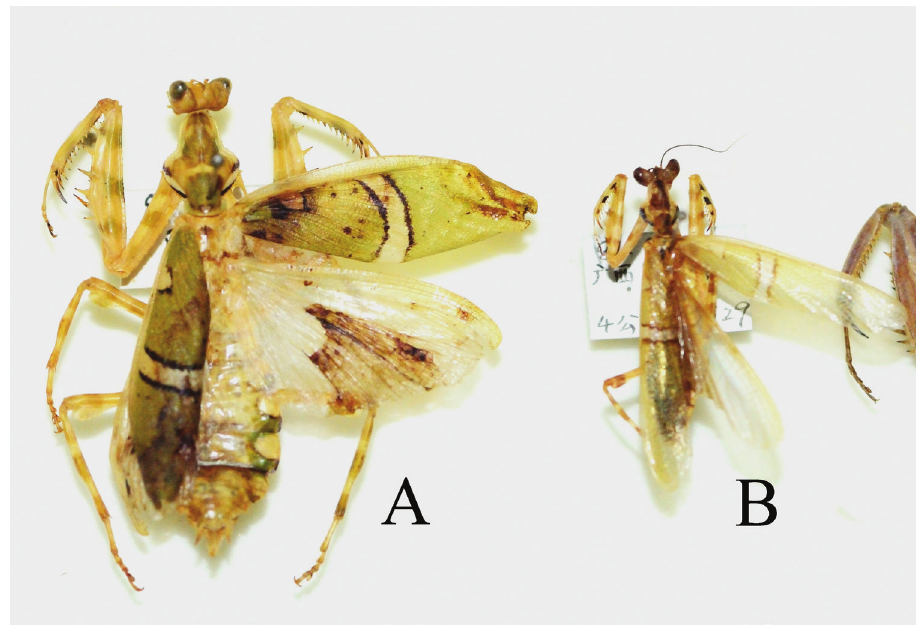
Figure 11. Holotype and paratype of Theopropus sinecus Yang, 1999 A holotype, female B paratype,